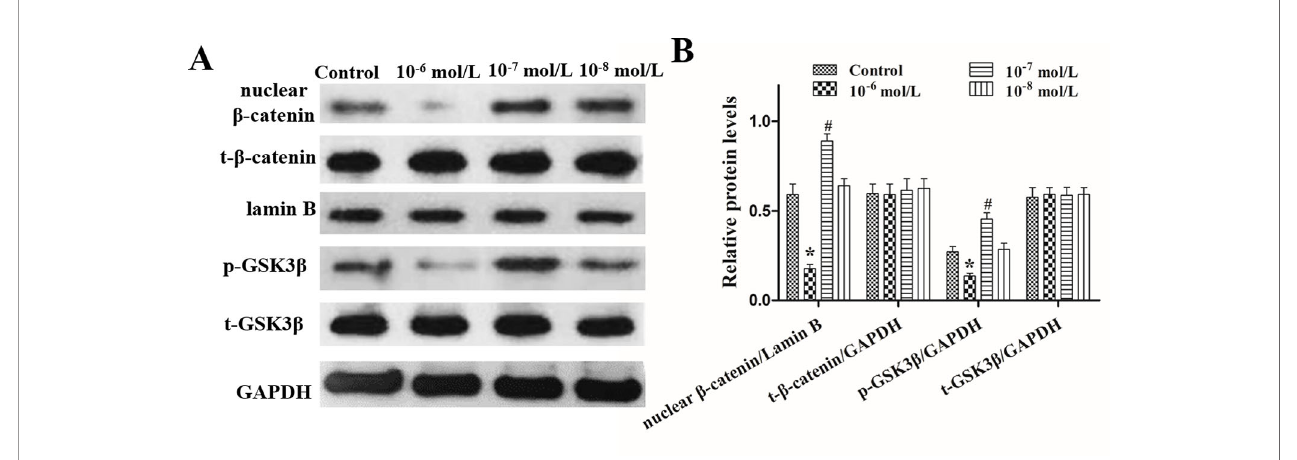
FIGURE 7 | Effects of different concentrations of dihydrotestosterone (DHT) on the expression of b -catenin, GSK3 b , and p-GSK3 b (ser9) in C57BL/6 mice. The nucleoproteins and total proteins of the back skin were extracted for Western blot. (A) Western blot analysis of the expression of nuclear b -catenin, total b -catenin (t- b - catenin), total GSK3 b (t-GSK3 b ), and p-GSK3 b (ser9) (p-GSK3 b ) in the back skin. (B) The statistical results of Western blot analysis. The data are presented as the mean ± SD (n = 5). Each bar represents the mean of three independent experiments performed in triplicate. Compared with the control group, * P < 0.05 and # P <